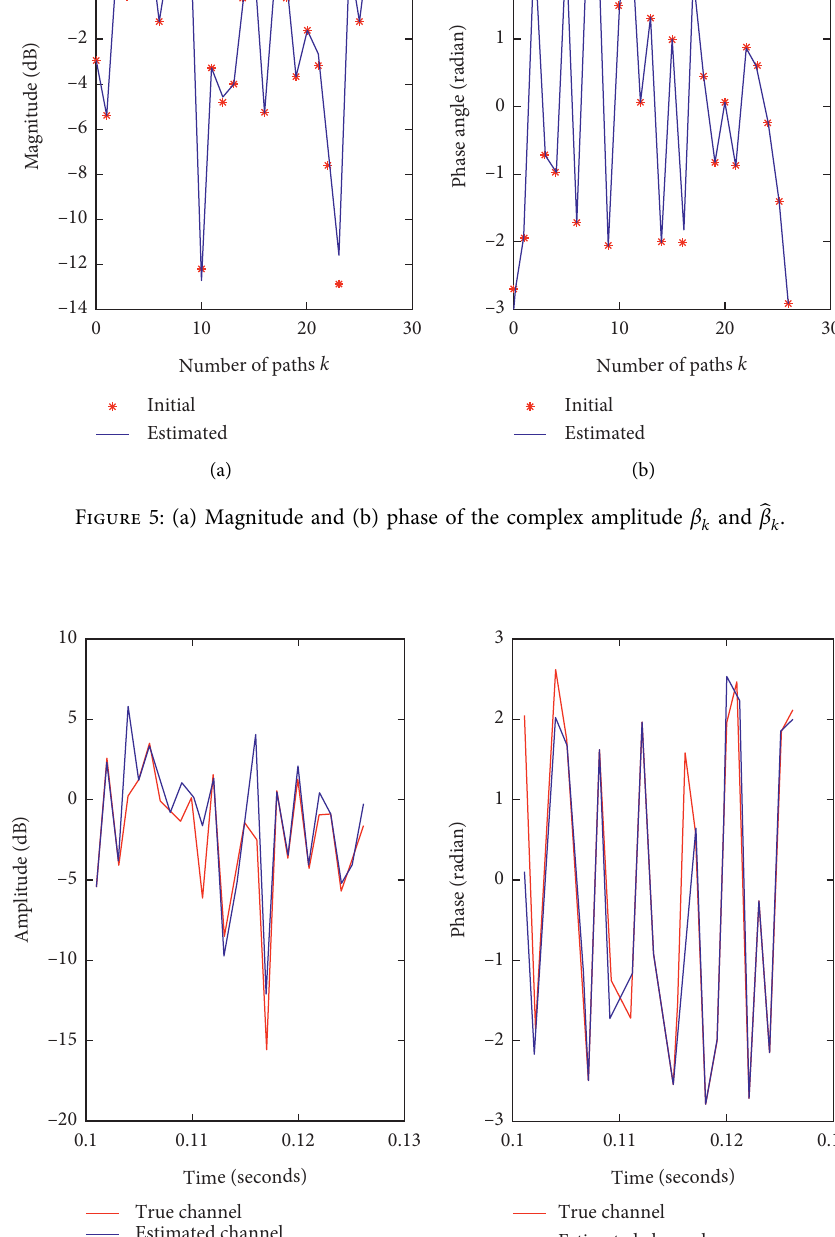
Figure 6: (a) Magnitude and (b) phase of 􏽢 h and h